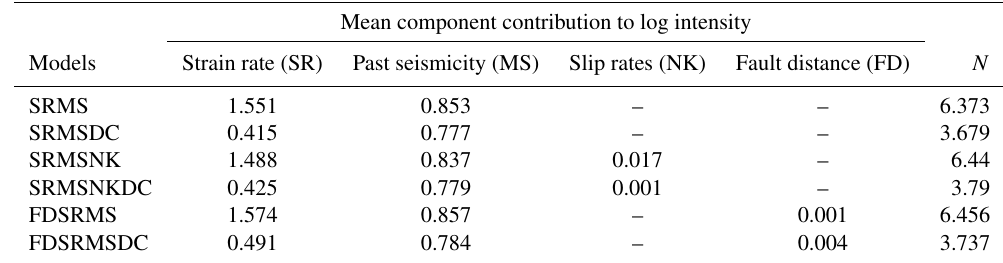
Table 1. Posterior means of model components and number of expected events for full and declustered (DC) models.